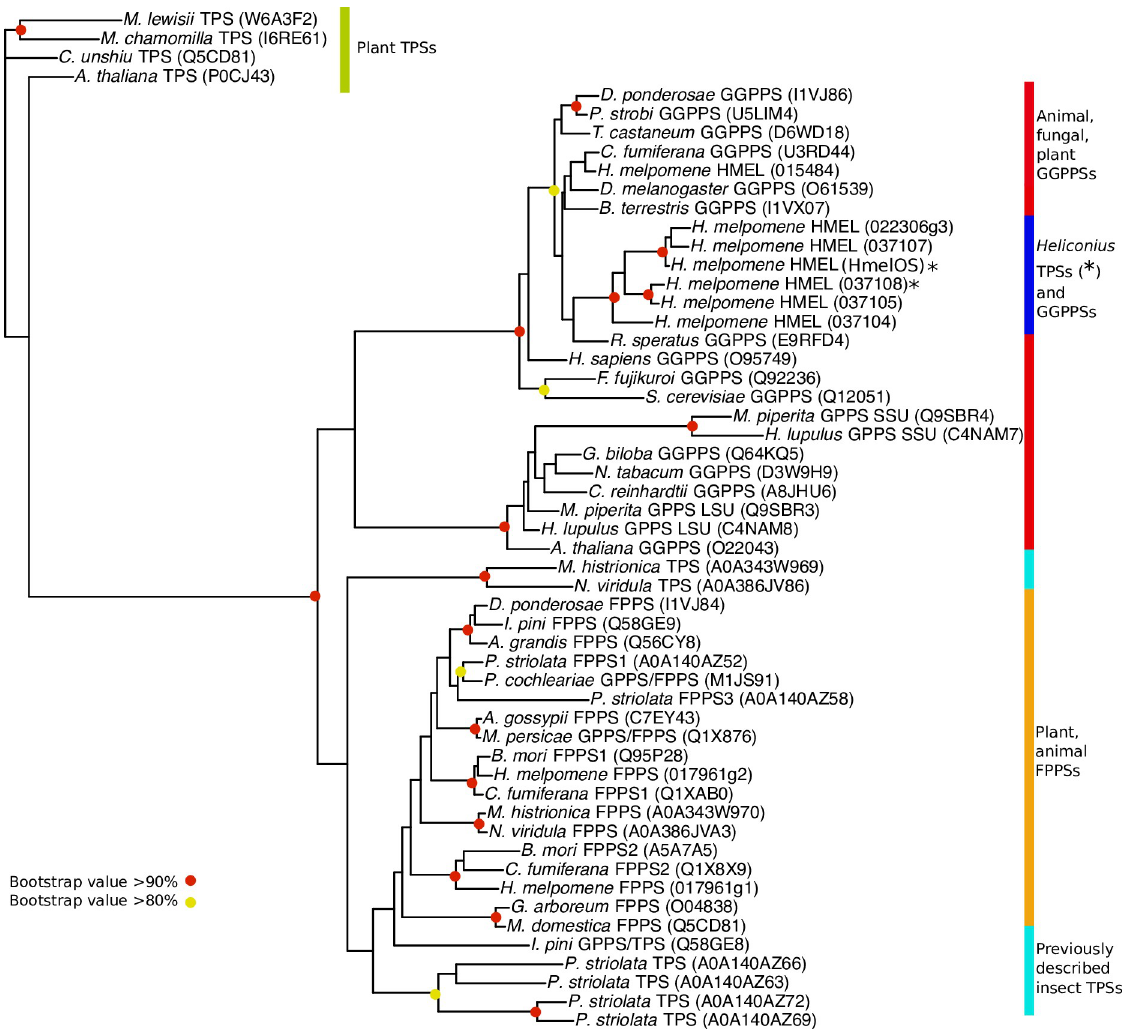
Fig 4. Phylogram of GGPPS, FPPS, and TPS proteins of animals, fungi, and plants. The phylogeny was constructed by PhyML using LG model of amino acid evolution. Bootstrap ( n = 1000) values are illustrated. The tree was rooted with the ocimene synthase of Citrus unshiu . Full species names in S14 Table. Script is available from OSF (https://osf.io/3z9tg/). FPPS, farnesyl diphosphate synthase; GGPPS, geranylgeranyl diphosphate synthase; TPS, terpene